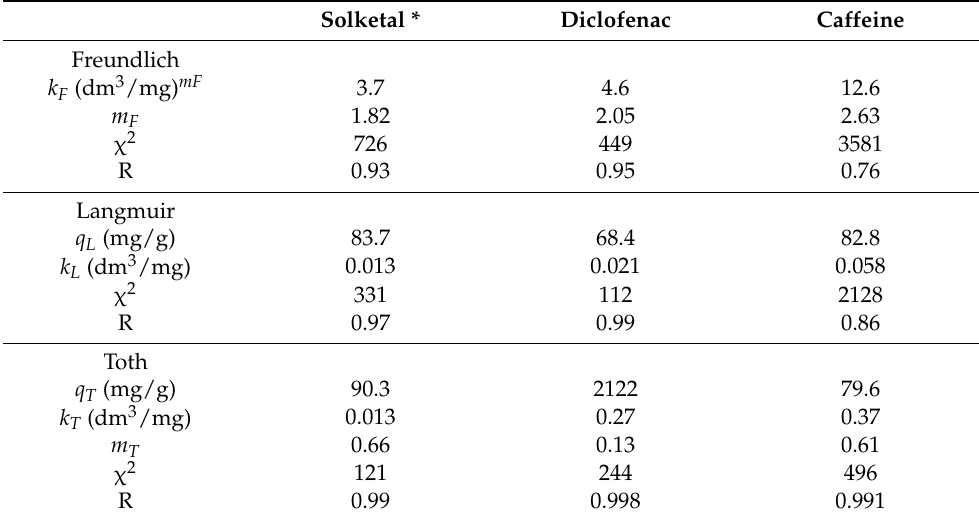
Table 2. Freundlich, Langmuir, and Toth parameters for adsorption by the AC. Equilibrium time = 7 h, T = 298 K.